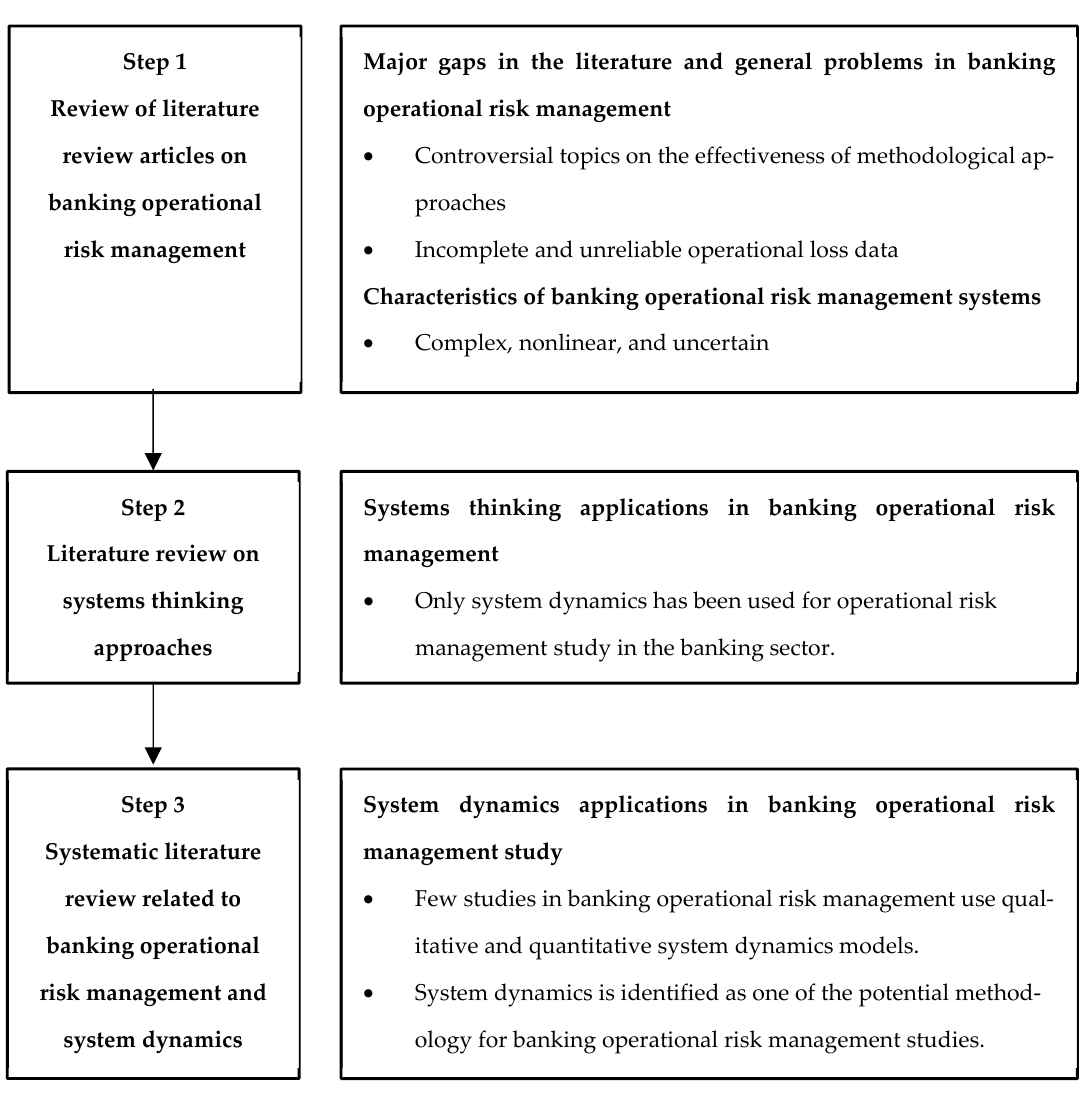
Figure 2. A summary of key findings from the test of the proposed methodology for literature review on operational risk management in banks.